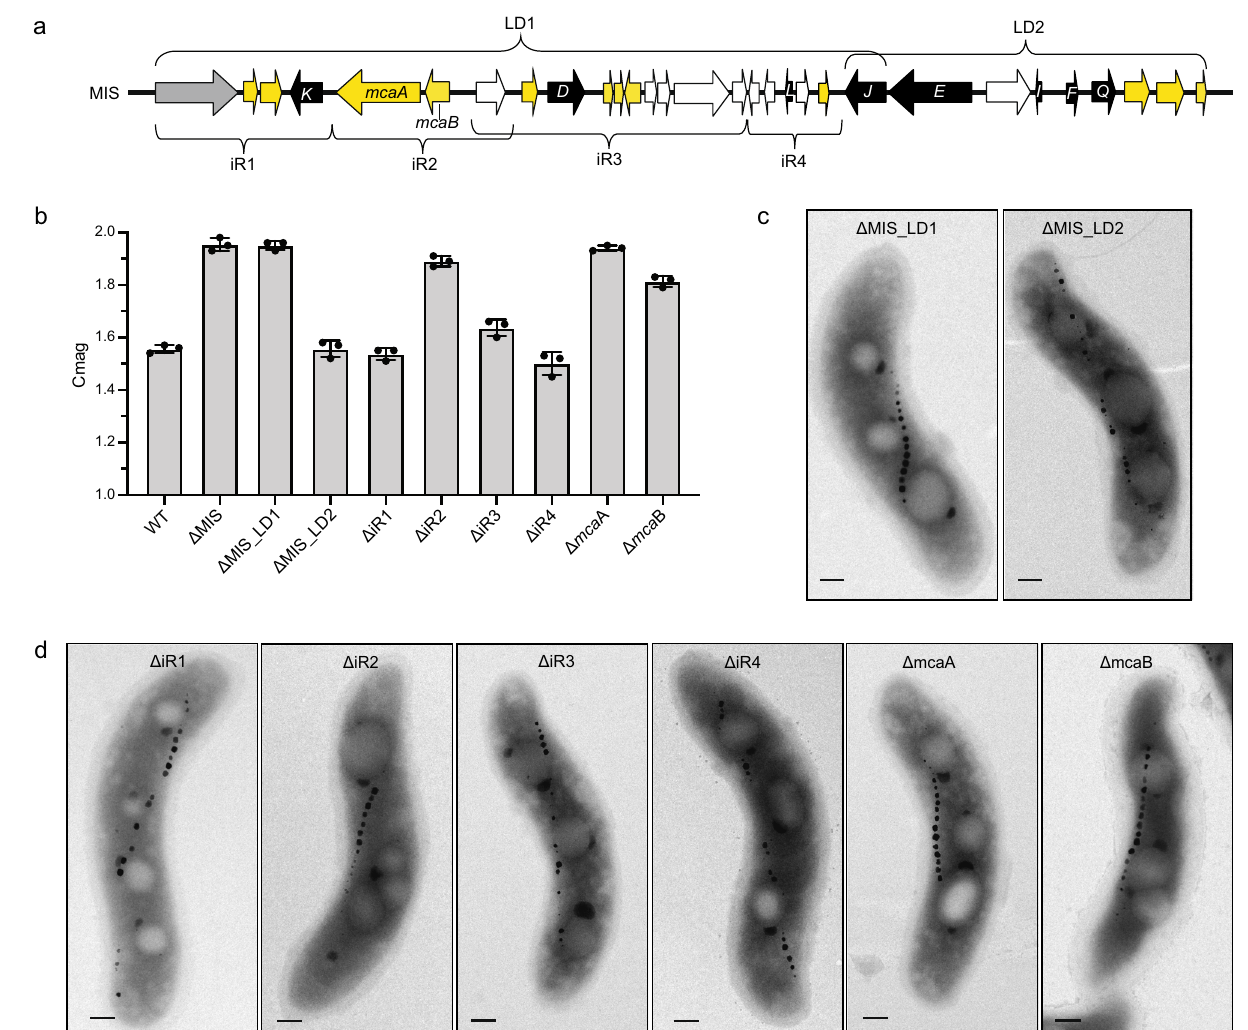
Fig. 3 | Comprehensive genetic dissection of the MIS genes. a Schematic depicting the MIS region of AMB-1, including the predicted magnetosome gene homologs (black), the gene of a phage-associated protein (gray), the genes of transposases (white), and the hypothetical genes (yellow). LD1 and LD2, large domains 1 and 2. iR1-iR4, small islet regions 1 – 4. K , mamK-like ; D , mamD-like ; L , mamL-like ; J , mamJ-like ; E , mamE-like ; I , mamI-like ; F , mamF-like ; Q , mamQ-like .